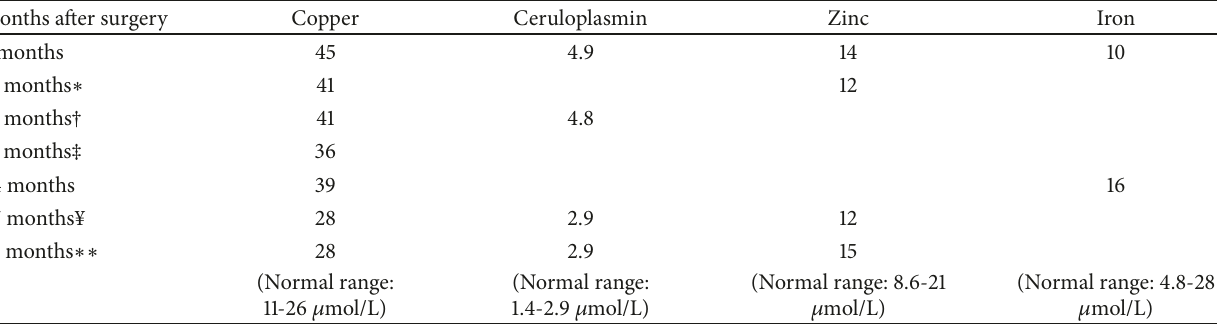
Table 1: Summary of biochemical findings.